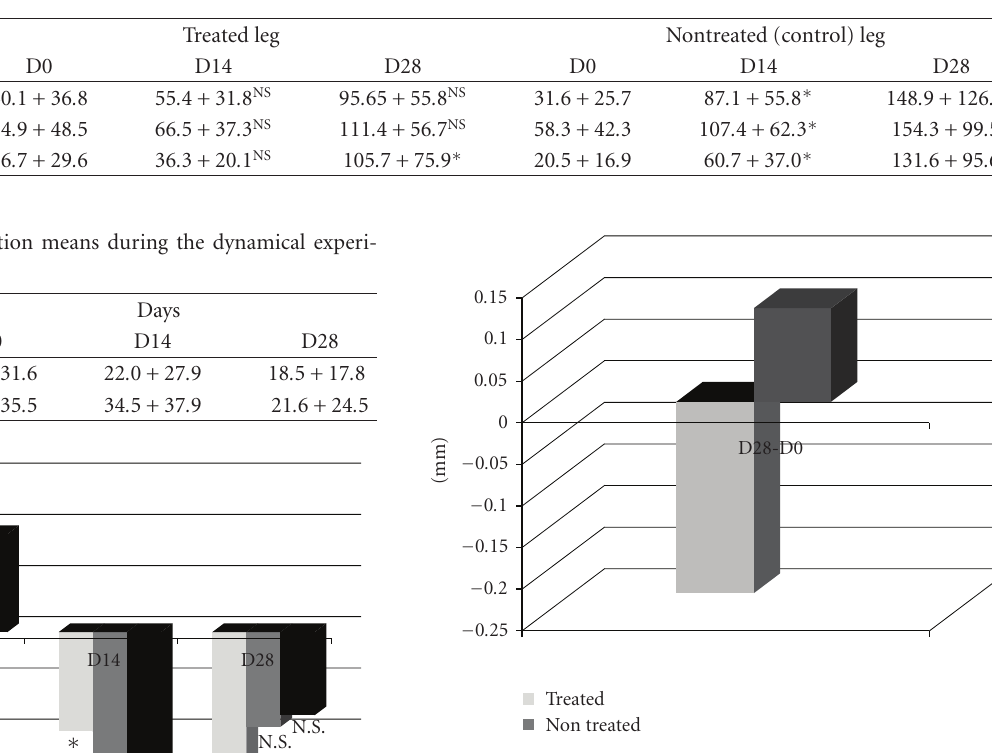
Table 1: Skin microcirculation blood flow obtained during single (basal) and dynamical (Provocation, Postprovocation) measurements at each evaluation day ( ∗ P < . 05; NS: Nonsignificant: Comparison against D0).